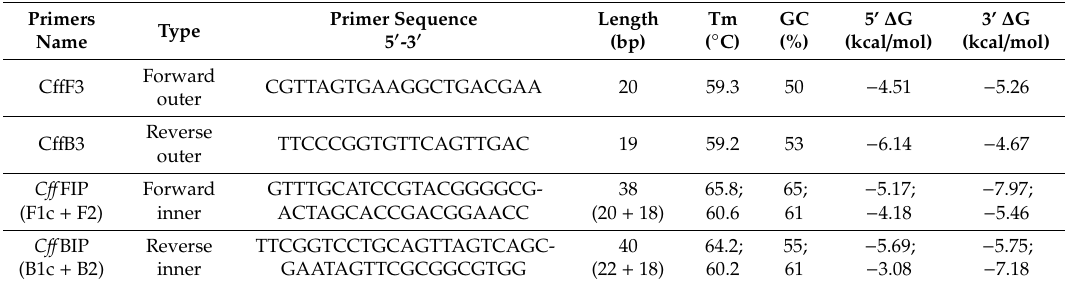
Table 2. Sequences and features of the LAMP primers designed and used in this study for C ff specific